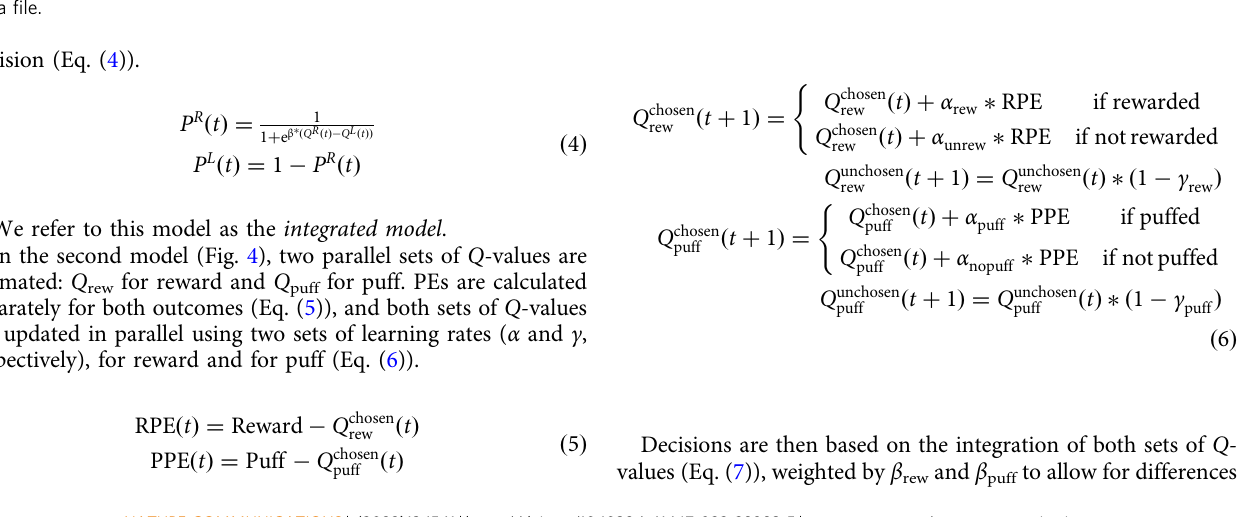
Fig. 3 Combined reward – puff representations in single neurons do not always re fl ect outcome value. a Percentage (mean ± SEM) of reward-selective (puff: 27.6 ± 3.6%; no puff: 9.7 ± 2.2%) and no-reward-selective (puff: 29.0 ± 4.2%; no puff: 9.7 ± 1.6%) neurons that were selective for the puff outcome, as identi fi ed using chi-square analysis ( n = 13 mice for all panels, average percentage per mouse is shown). There was a signi fi cant main effect of the percentage of puff neurons ( p = 1e − 7, repeated measures ANOVA) but no reward – puff interaction ( p = 0.83). b Percentage of puff- and no-puff-selective neurons that were selective for reward/no-reward outcome (puff selective: reward: 16.9 ± 3.2%, no reward: 24.8 ± 3.7%; no-puff-selective: reward: 28.7 ± 7.4%, no reward: 34.5 ± 4.6%, mean ± SEM, n = 13). There was a signi fi cant main effect of puff neurons ( p = 0.044, repeated measures ANOVA) but no interaction between reward and puff ( p = 0.84). c A stepwise regression analysis identi fi ed neurons with reward and puff outcome interactions. Session-averaged activity of these neurons is shown for trials with different reward – puff combinations. d Neurons were split into value and non-value type based on whether they responded to reward and puff oppositely or not. The proportion of neurons classi fi ed to these two types was not different (value: 15.6 ± 2%, non-value: 14.5 ± 2%, mean ± SEM percentage across 13 mice). e The selectivity of value and non-value neurons in ( d ) is not signi fi cantly different for reward (left panel; value: 0.74± 0.01 (mean ± SEM), non-value: 0.71 ± 0.01, p > 0.05, t = 2.1, df = 12, two-sided paired t -test, n = 13) or puff (right panel; value: 0.69 ± 0.01, non-value: 0.67 ± 0.01, p > 0.05; t = 1.03, df = 12, two-sided paired t -test, n = 13). Source data are provided as a Source Data fi